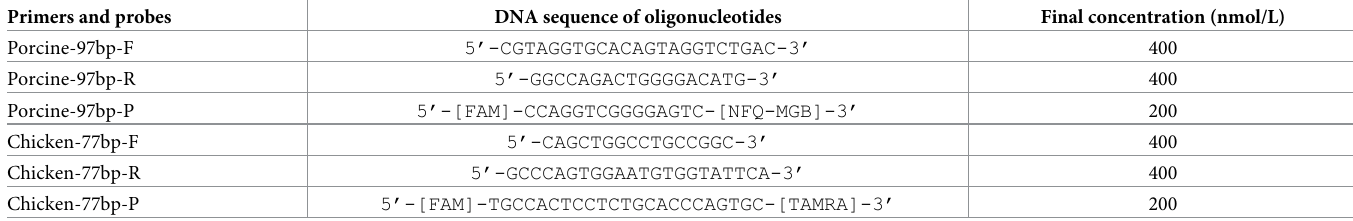
Table 1. DNA sequence of oligonucleotides used in this study.